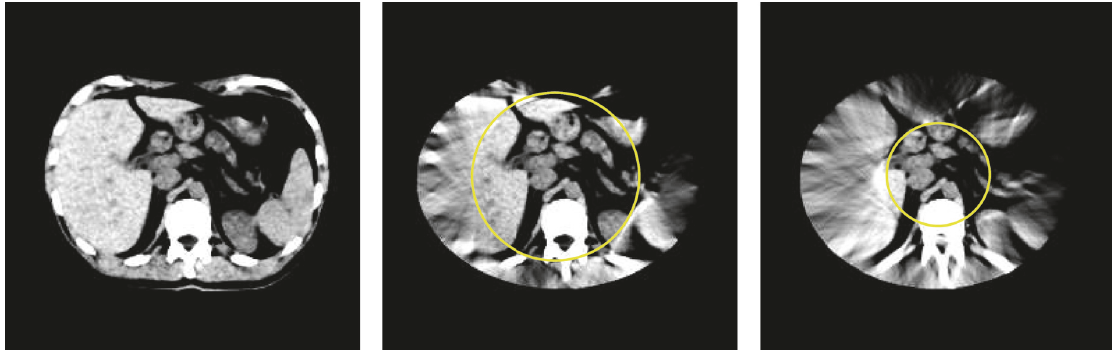
Figure 9: Reconstruction results of the reprojected body scan with both medium truncation and severe truncation. From left to right: the reference from nontruncated data, the proposed correction method with medium truncation, and the proposed correction method with severe truncation. The grayscale window: 𝐶 = 0 HU, 𝑊 = 400 HU. The yellow circles indicate the ROI.